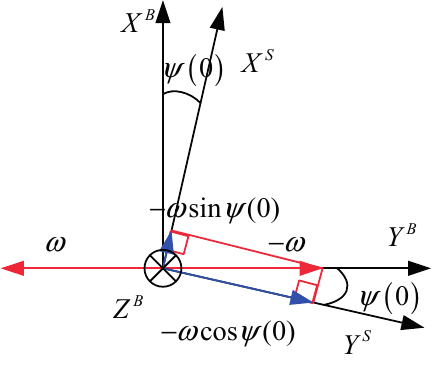
Figure 4. Misalignment of yaw effects gyro signals at other axis during Y-axis rotation.